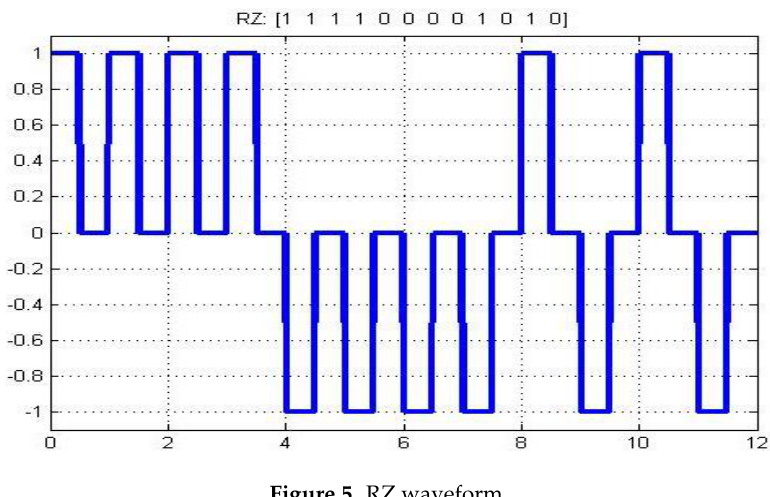
Figure 4. Shadow Encoding Scheme (SES)